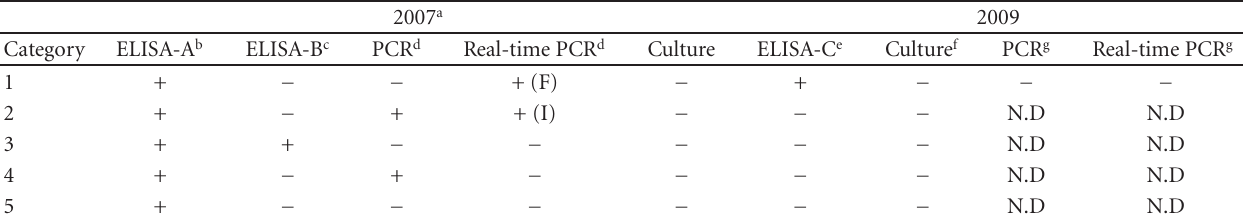
Table 6: Comparison of diagnostic test results of single animals ( n = 11) tested for Map in 2007 and in